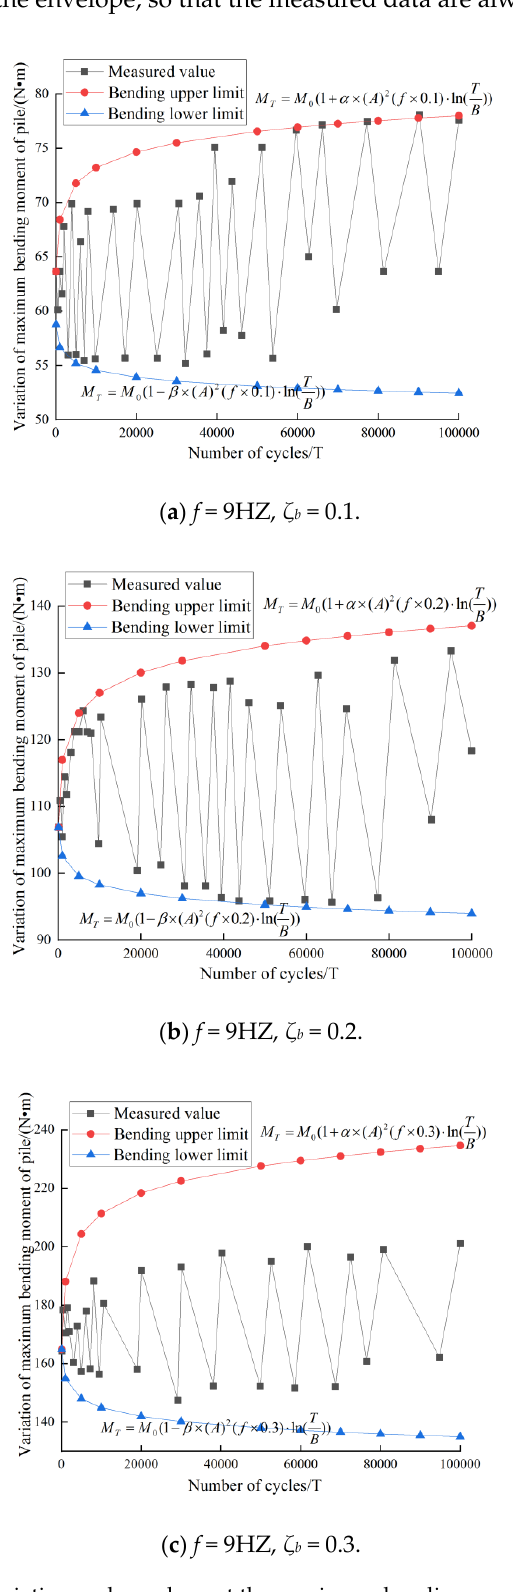
Figure 10. Variation and envelope at the maximum bending moment of pile.